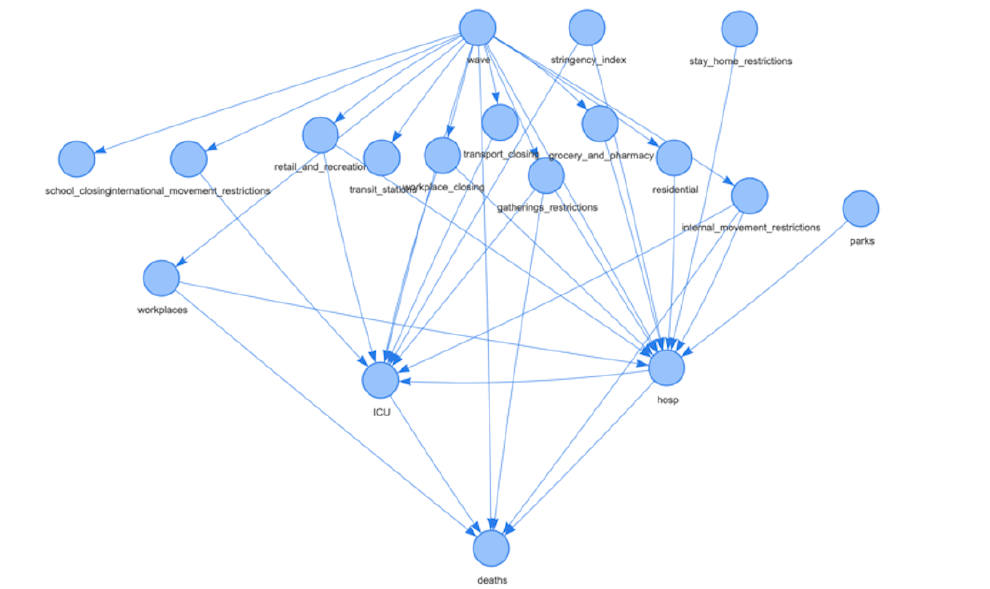
Figure 3. BN structure for Italy. The figure is downloadable at https://tinyurl.com/rbexhtww (accessed on 26 February 2022).